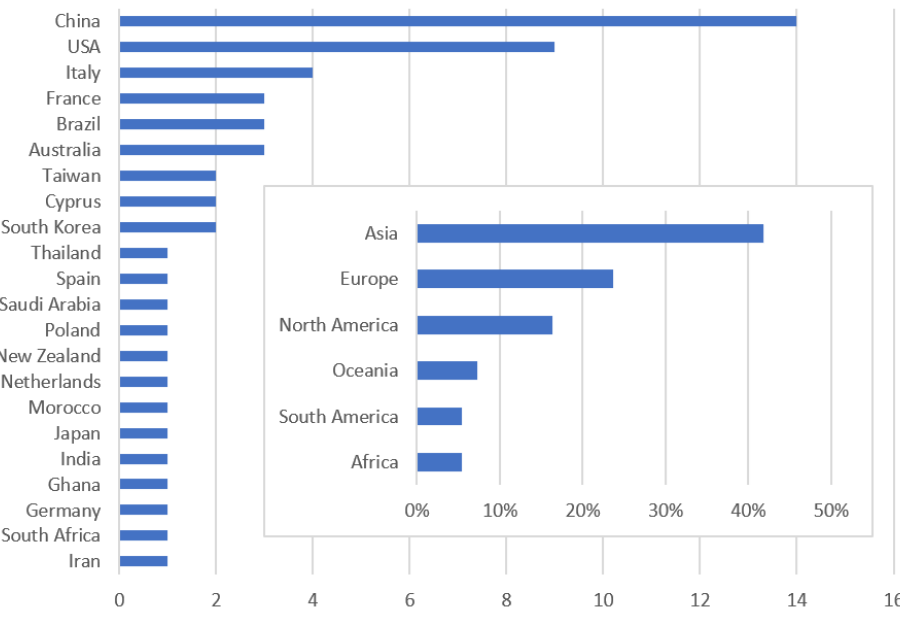
Figure 4. Distribution of published documents by country and by continent.